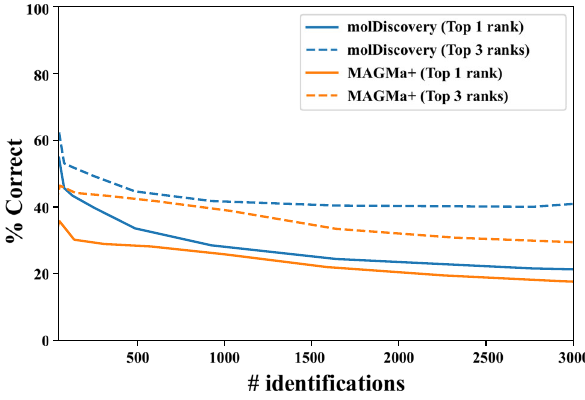
Fig. 6 Accuracy of high-throughput identi fi cation of the MoNA mass spectra against bioactive-PubChem. X-axis represents the number of identi fi cations. Y-axis shows the percentage of correct identi fi cations among the top identi fi